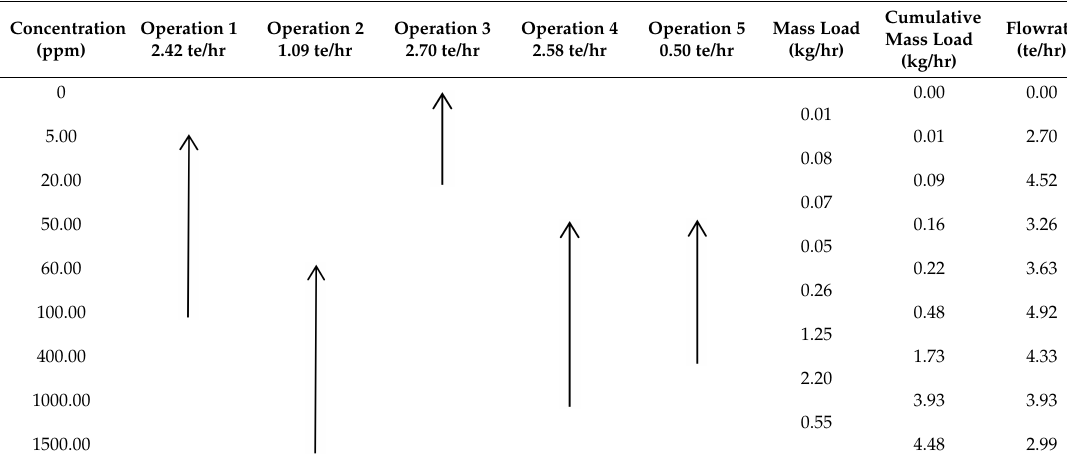
Table 3. Concentration interval diagram of the water system.